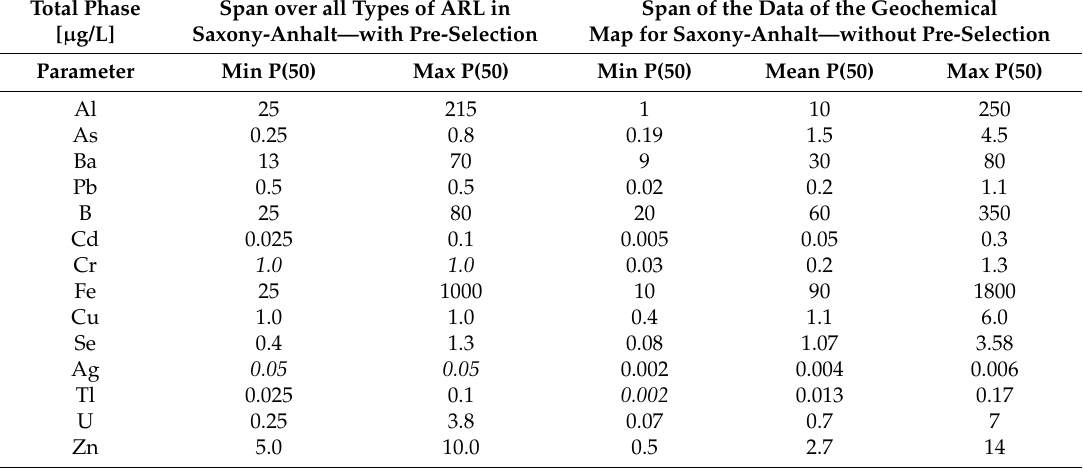
Table 5. Span of the geogenic background concentrations P(50) of total metals and metalloids in the rivers of Saxony-Anhalt classified by the aggregated riverine landscapes in comparison with the data of Birke et al. [41] (for ARL with pre-selection of data, 50th and 90th percentiles, for all elements the database is n > 20), italics represent data below the detection